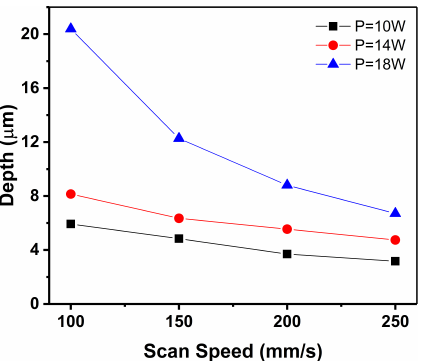
Figure 4. Effect of laser power and scan speed on